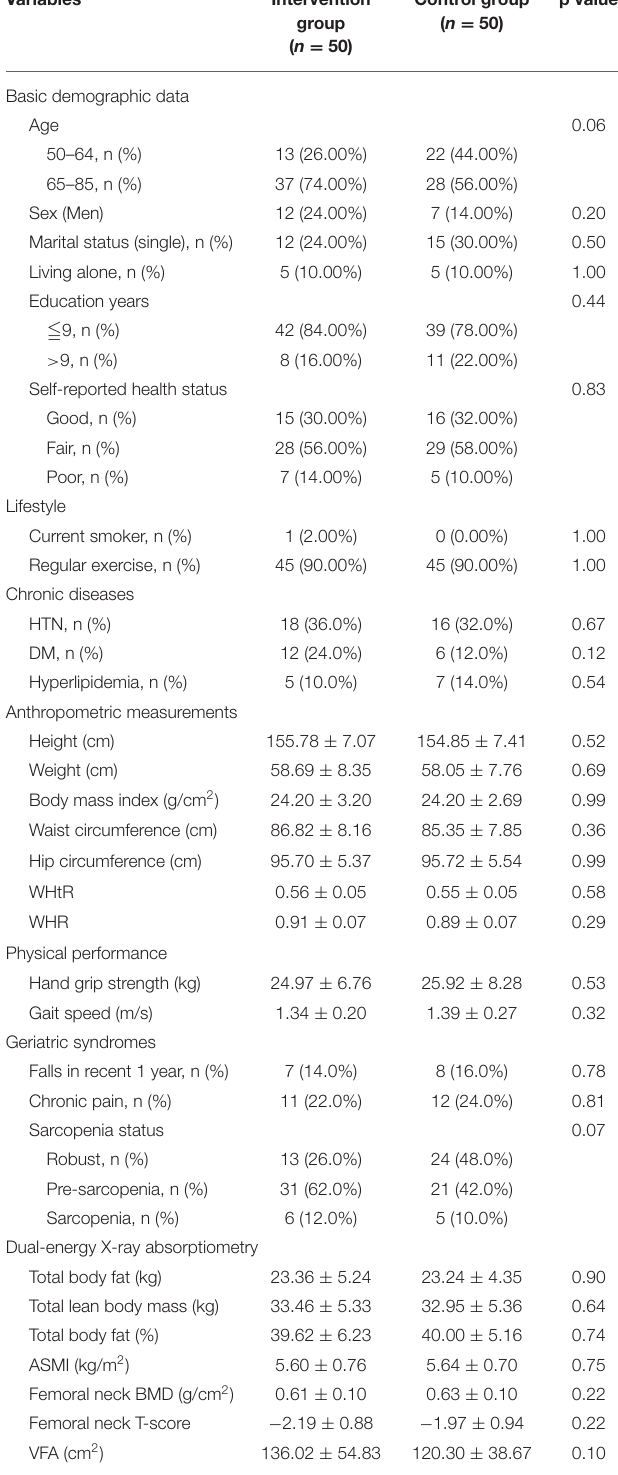
TABLE 2 | Baseline characteristics of the study population between intervention and control groups.